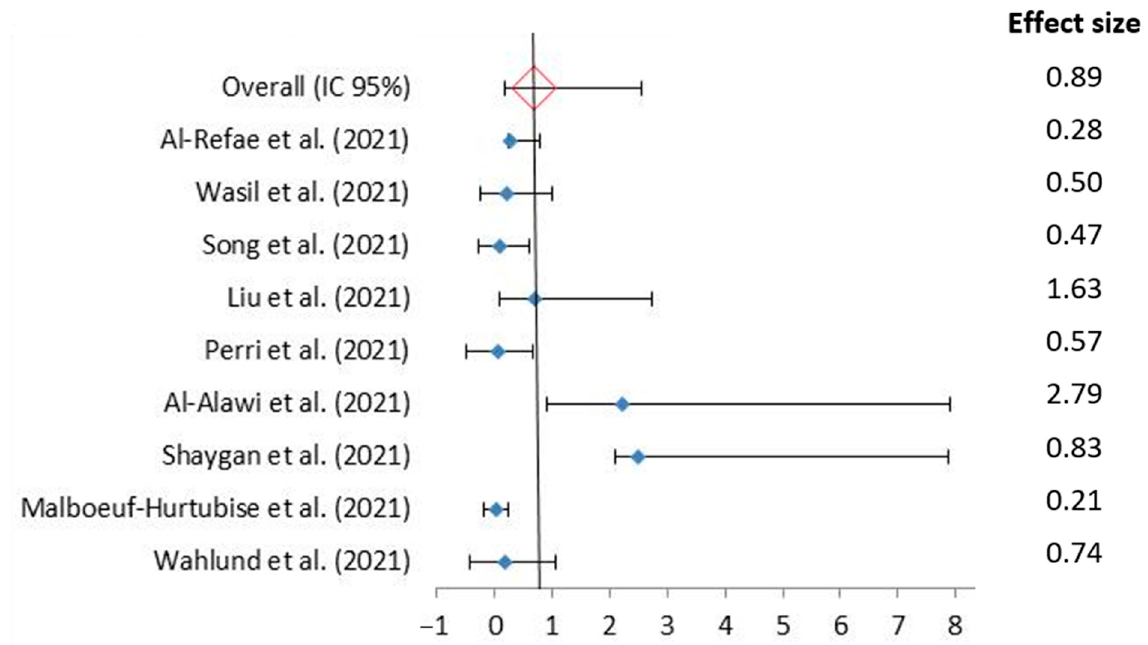
Figure 3. Forest plot of the psychological intervention effect during the SARS-CoV-2 pandemic Using Random Effects Model [20–28]. Squares indicate the OR of individual studies, and the extended lines denote 95% confidence intervals (CI). The diamond data indicates pooled prevalence. Test of heterogeneity: I 2 = 99.99%, p = 0.00.